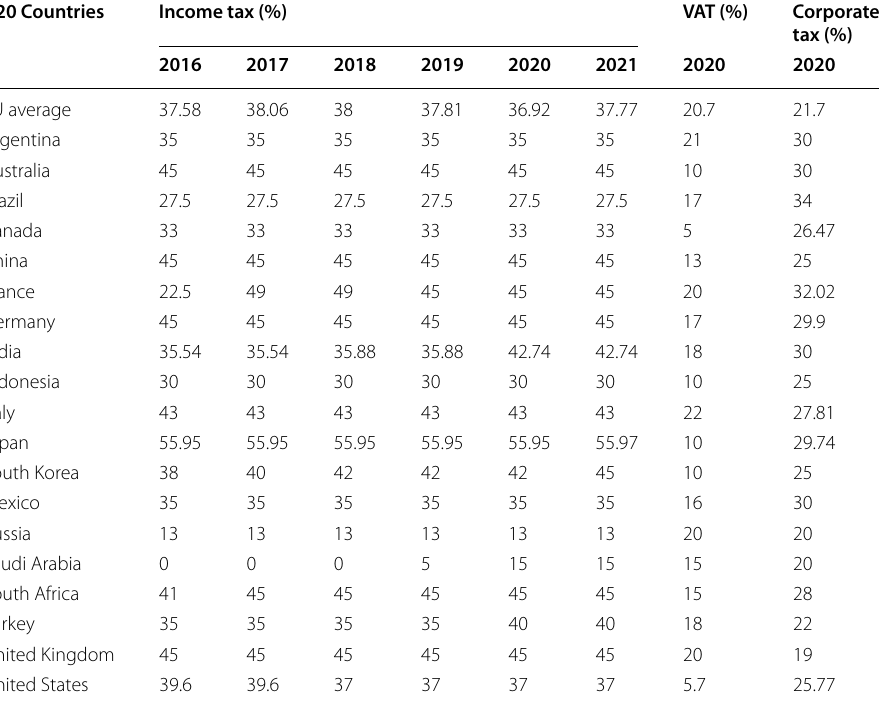
Table 8 G20 countries (excluding EU) income, VAT, and corporate tax rates (%) G20 Countries